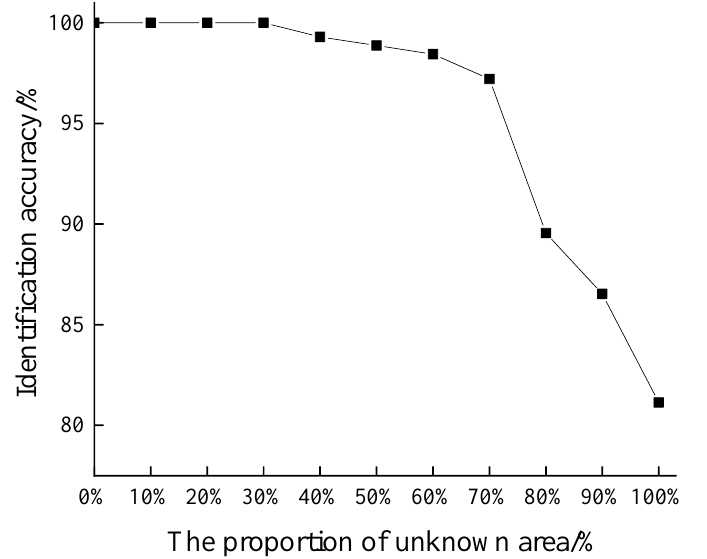
Figure 11. The proportion of unknown area voltage data in the station area in relation to the